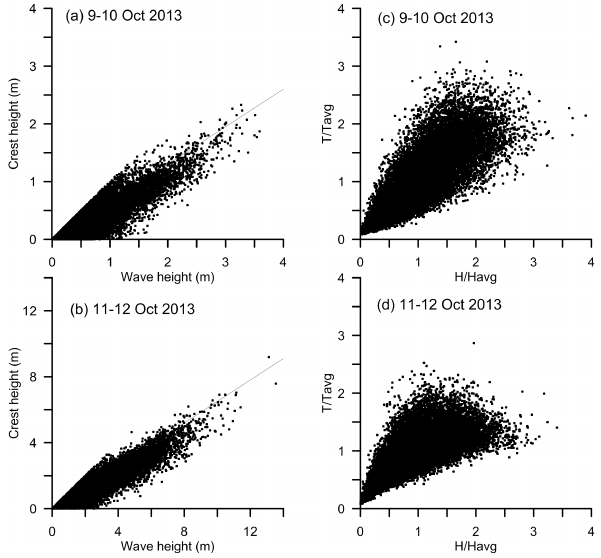
Figure 9. Relationship between crest height and wave height (a) be- fore the cyclone and (b) during the cyclone. Joint distribution of normalised period and height (c) before the cyclone and (d) during the cyclone. Figure 10. Joint distribution of wave height and period of the high waves. The contours indicate the probability